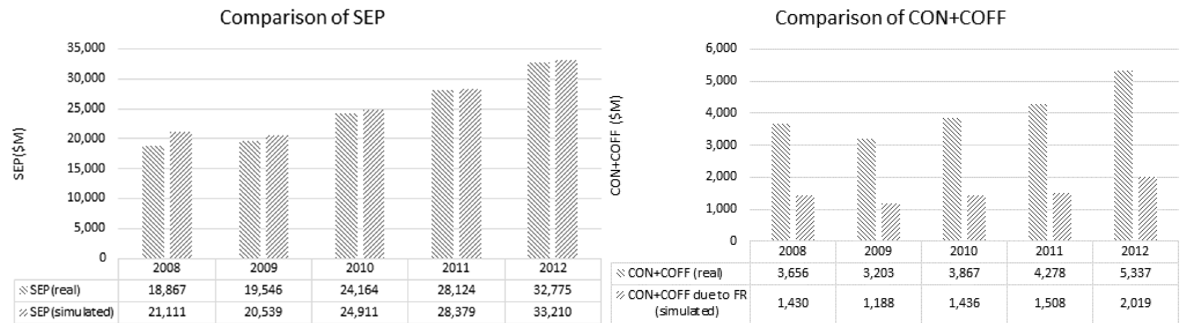
Figure 5. Comparison of simulation results with real